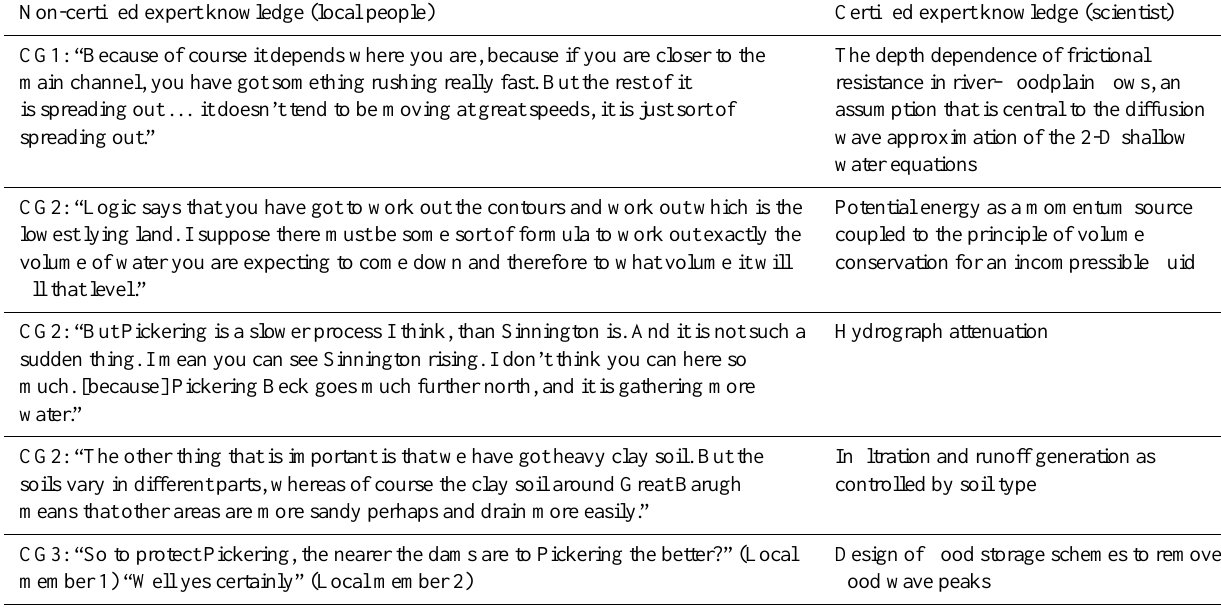
Table 1. A comparison of non-certified expert knowledge, as recorded during an experiment in public participation in flood risk management (Lane et al., 2011b), with the equivalent description that a certified expert (a scientist) might make of the same phenomenon. CG stands for “Competency Group” (see below) and the number refers to the meeting